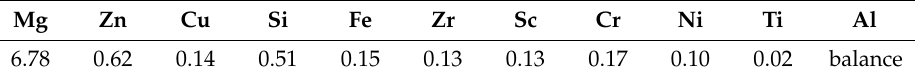
Table 1. Chemical composition of tested 1579 Al alloy in weight